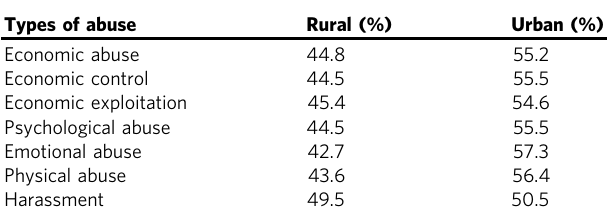
Table 3 Abuses experienced by women in rural and urban